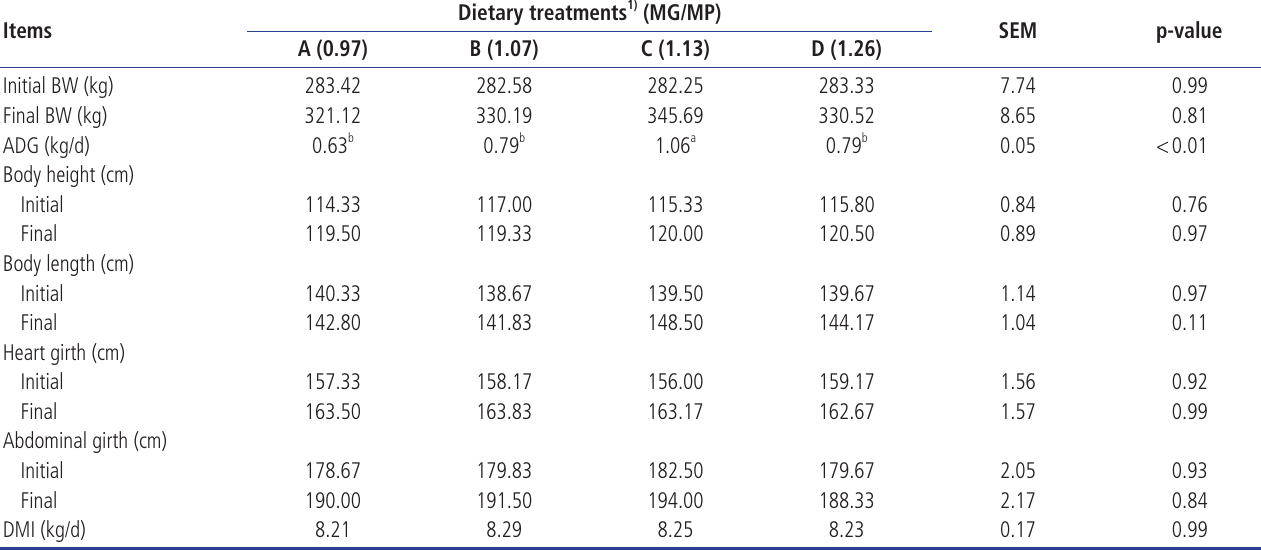
Table 3. Effects of increasing dietary MG/MP ratio on growth performance and DMI of 8 to 10-month-old heifers